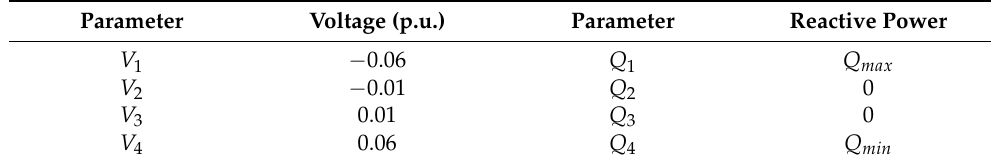
Table 1. VEC curve parameter settings.